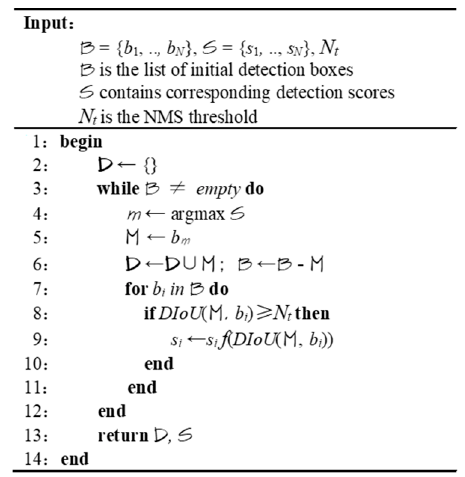
Figure 7. The pseudo code of DIoU Soft-NMS.